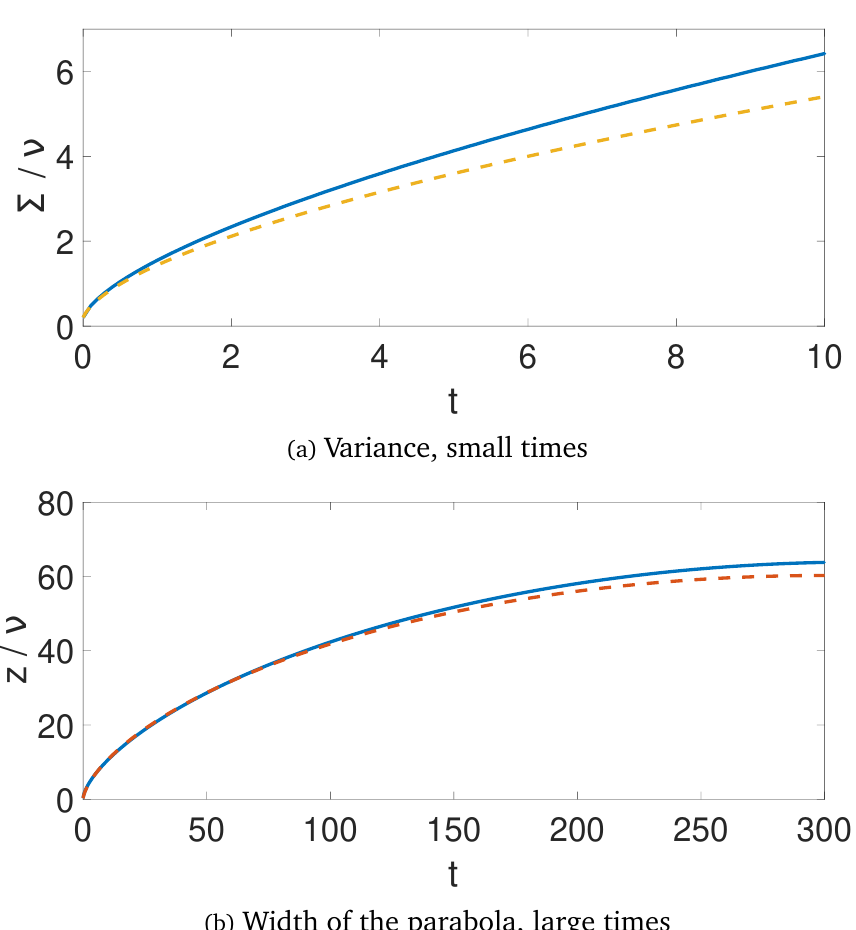
Figure 5: Time evolution of the variance (a) and the width of the parabola (b). The numerical solution for the density of players has been numerically fitted with a Gaussian and an inverted parabola, full curves are obtained through the extraction of the fitting parameters. Dashed curves are obtained using either the Gaussian or parabolic ansatz with energy E = − 9.95 × 10 − 3 computed through the self-consistent condition. Parameters for this figure are g = − 2, σ = 1.2, µ = 1, ν = 1, Σ